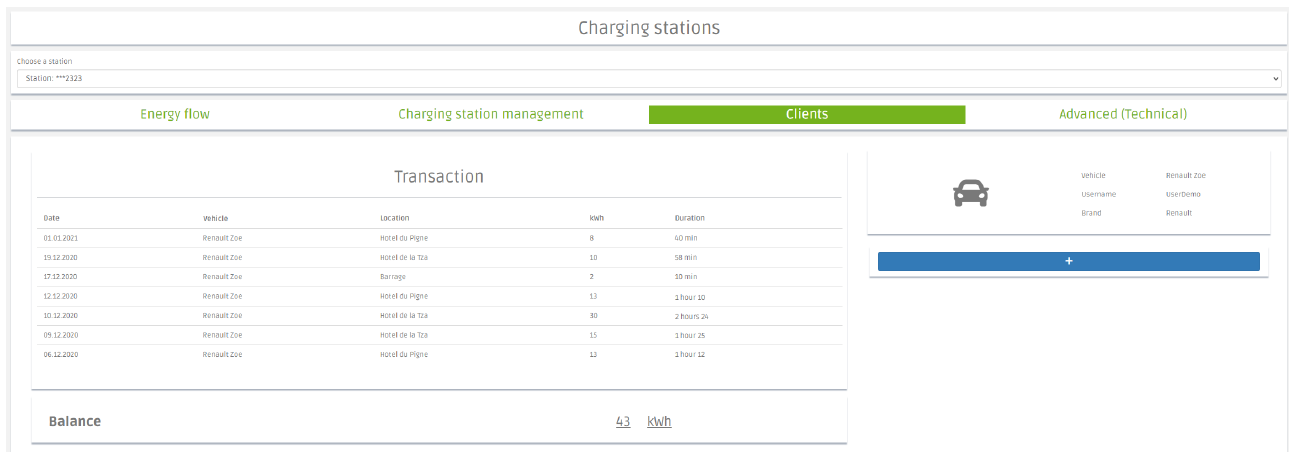
Figure 9. Clients tab on the web interface.